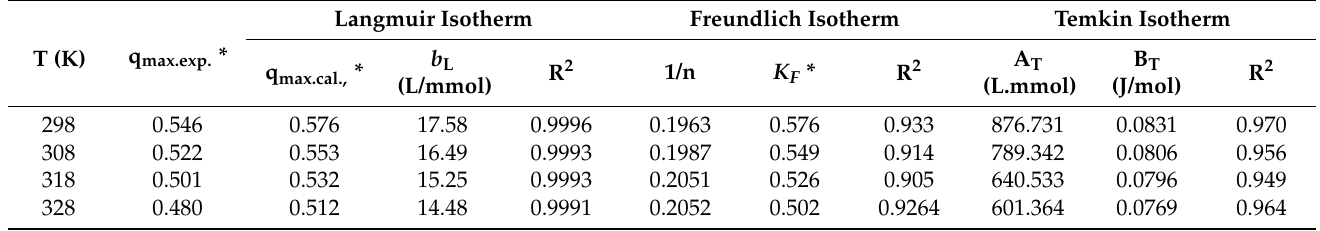
Table 3. Sorption isotherms for UO 22+ –the Langmuir, Freundlich, and Temkin equations all include model